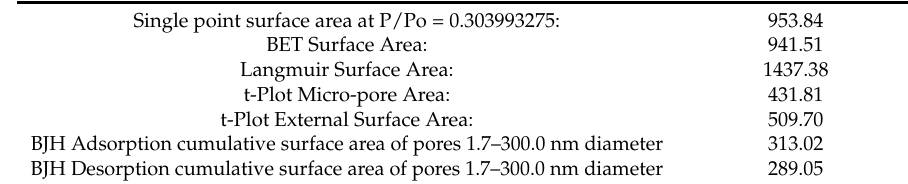
Table 1. Surface area (m 2 /g) characterization of activated carbon.